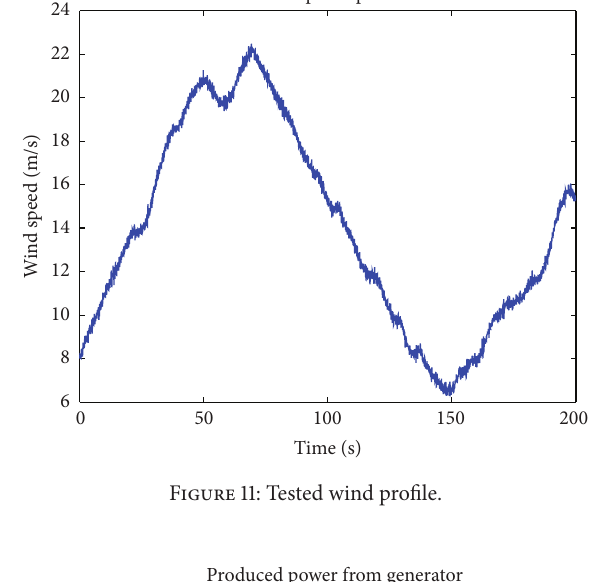
Table 1: Principal data of test wind turbine WindPACT 1.5.